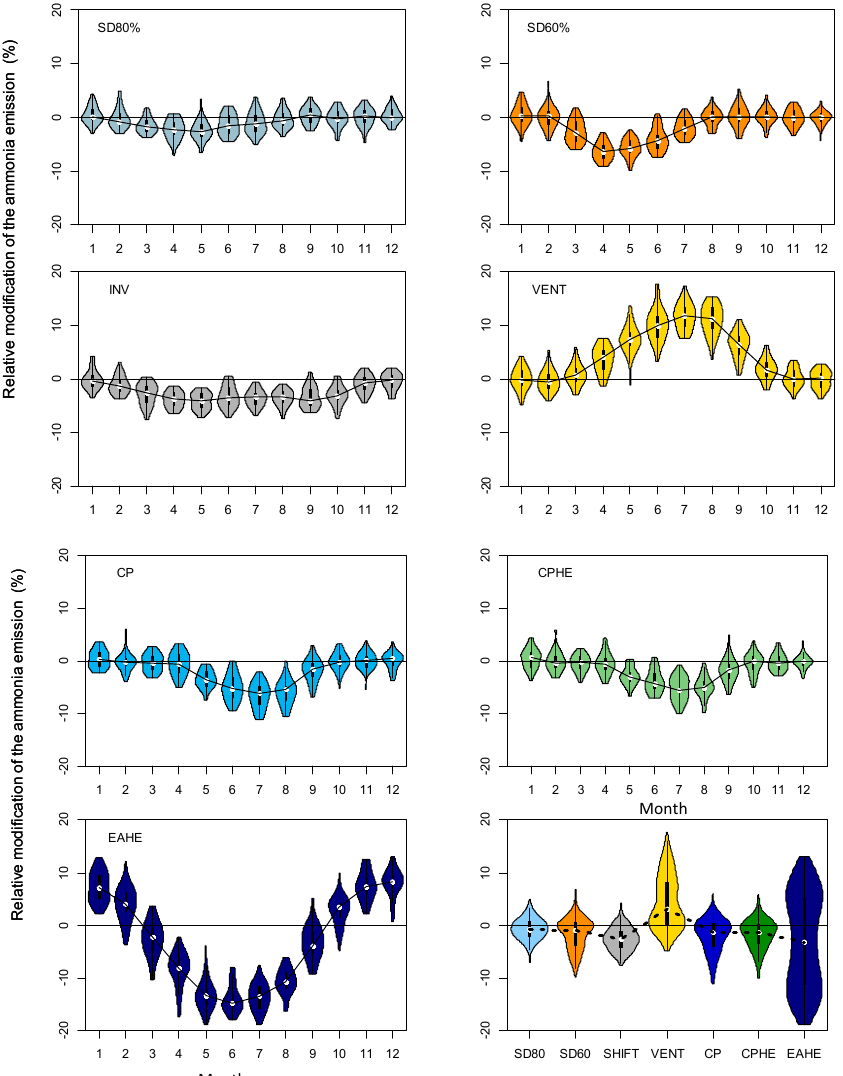
Figure 5. Violin plot of the relative modification of the NH 3 emission MOD (%) of the monthly mean values (period 1981–2017) for a specific AM and the reference building REF for all months and as an annual man value. Adaptation measures: stocking density SD80%; stocking density SD60%; inversion of the resting and activity periods INV; doubling the ventilation rate VENT; cooling pads CP and cooling pads and heat exchanger CPHE; and earth-air heat exchanger EAHE. The annual mean values of the relative difference of the ammonia emission (black dashed line), as well as their intra-annual spread, are shown in the lowest right graph.